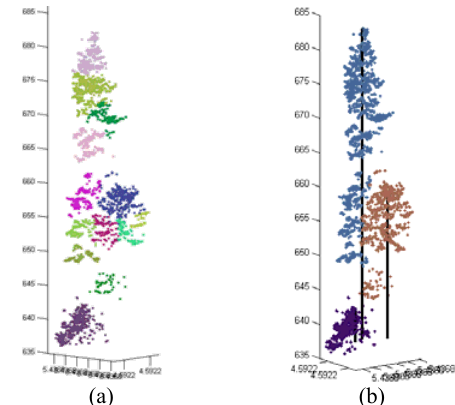
Figure 6 Single tree segmentation: from MS clusters (a) to 3D singles trees (b) based on global grouping by normalized